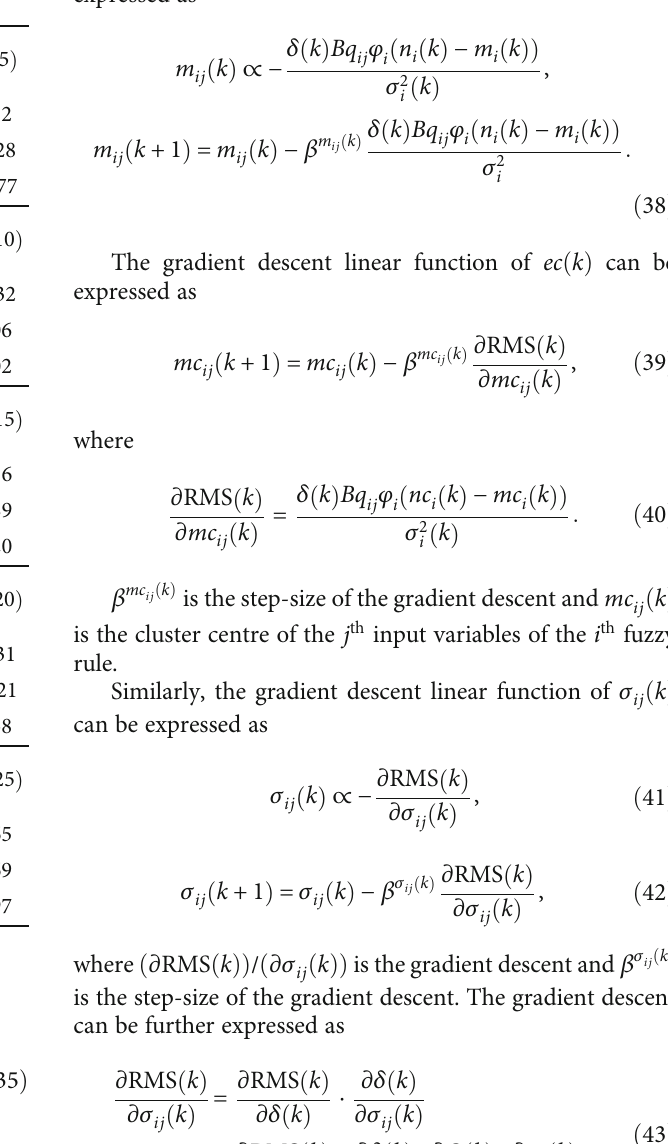
Table 13: Error change rate σ c